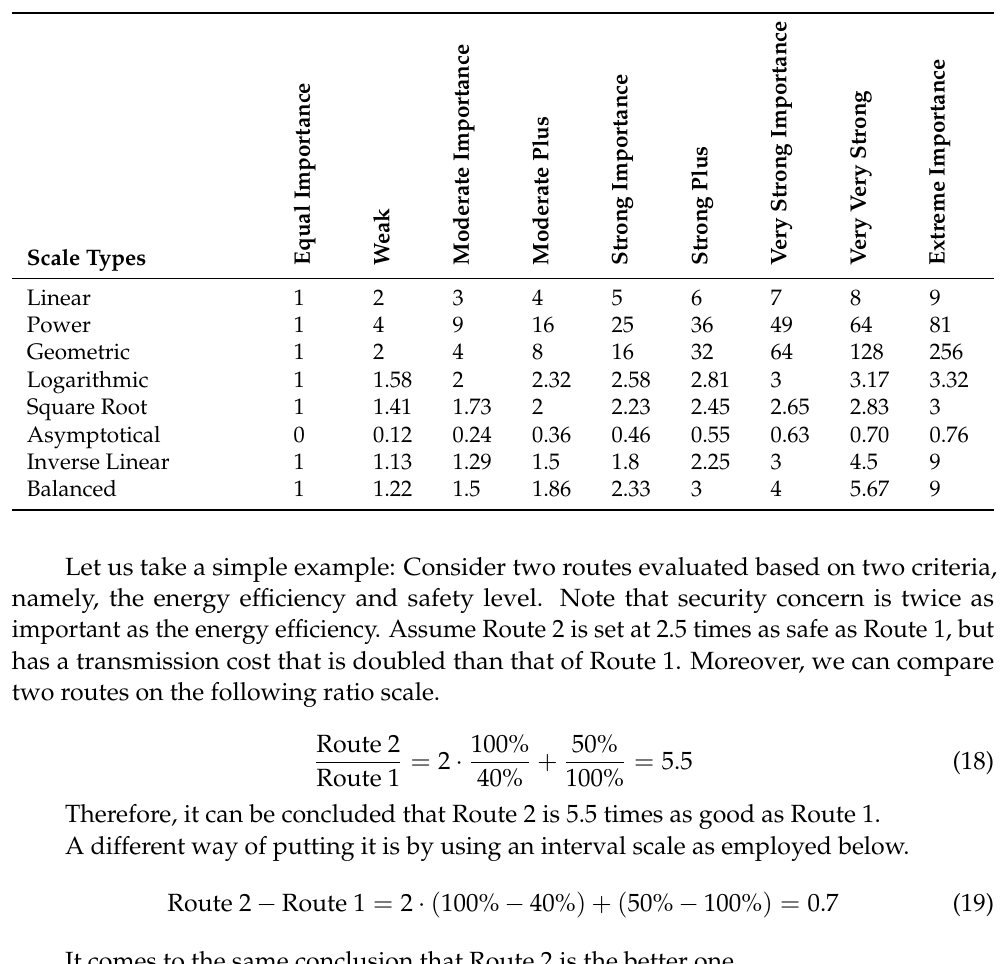
Table 5. Different scales of priority